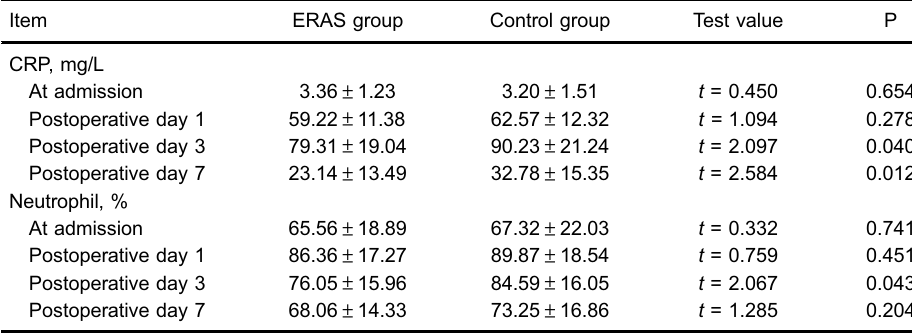
Table 6. Comparison of in fl ammatory indicators between the two groups of